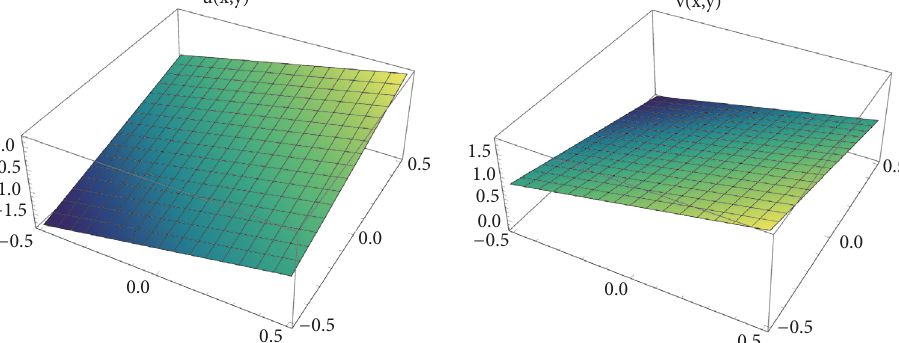
Figure 3: The approximate solution of Example 9 for 𝛼 = 0.99 and t = 0.2.